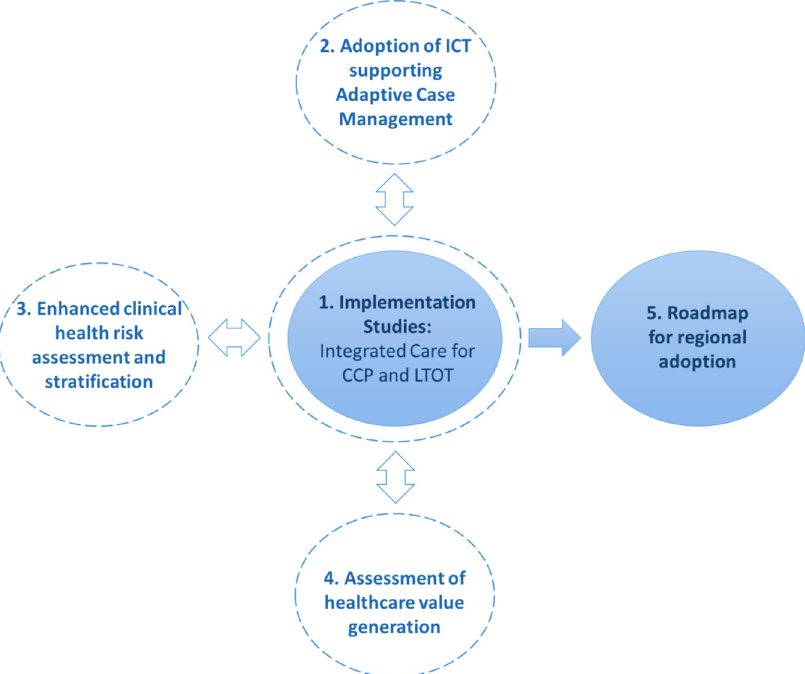
Fig. 1 Aims of the study. Five pivotal aims to achieve successful regional adoption of the community-based protocol for collaborative management of complex chronic patients across healthcare